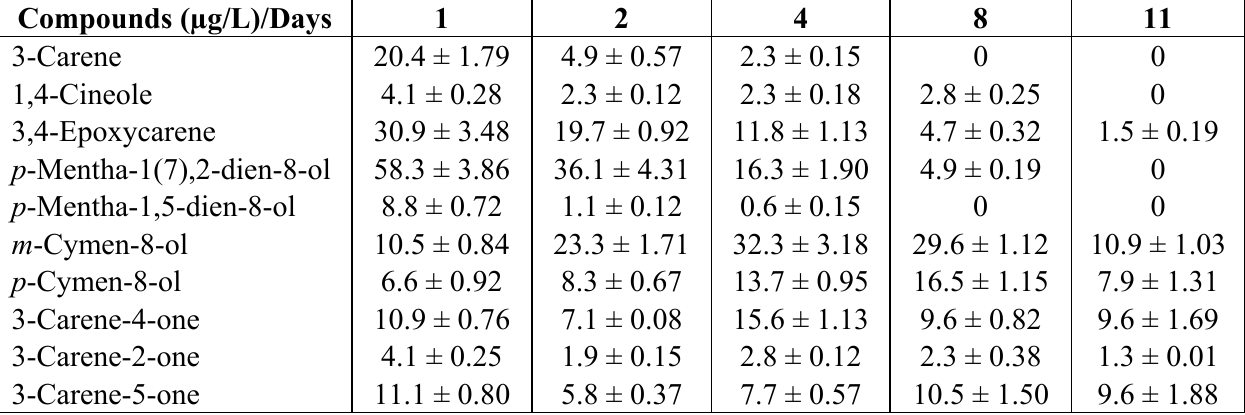
Table 1. The quantitative yields of (1 S )-3-carene ( 2 ) biotransformation products. Compounds